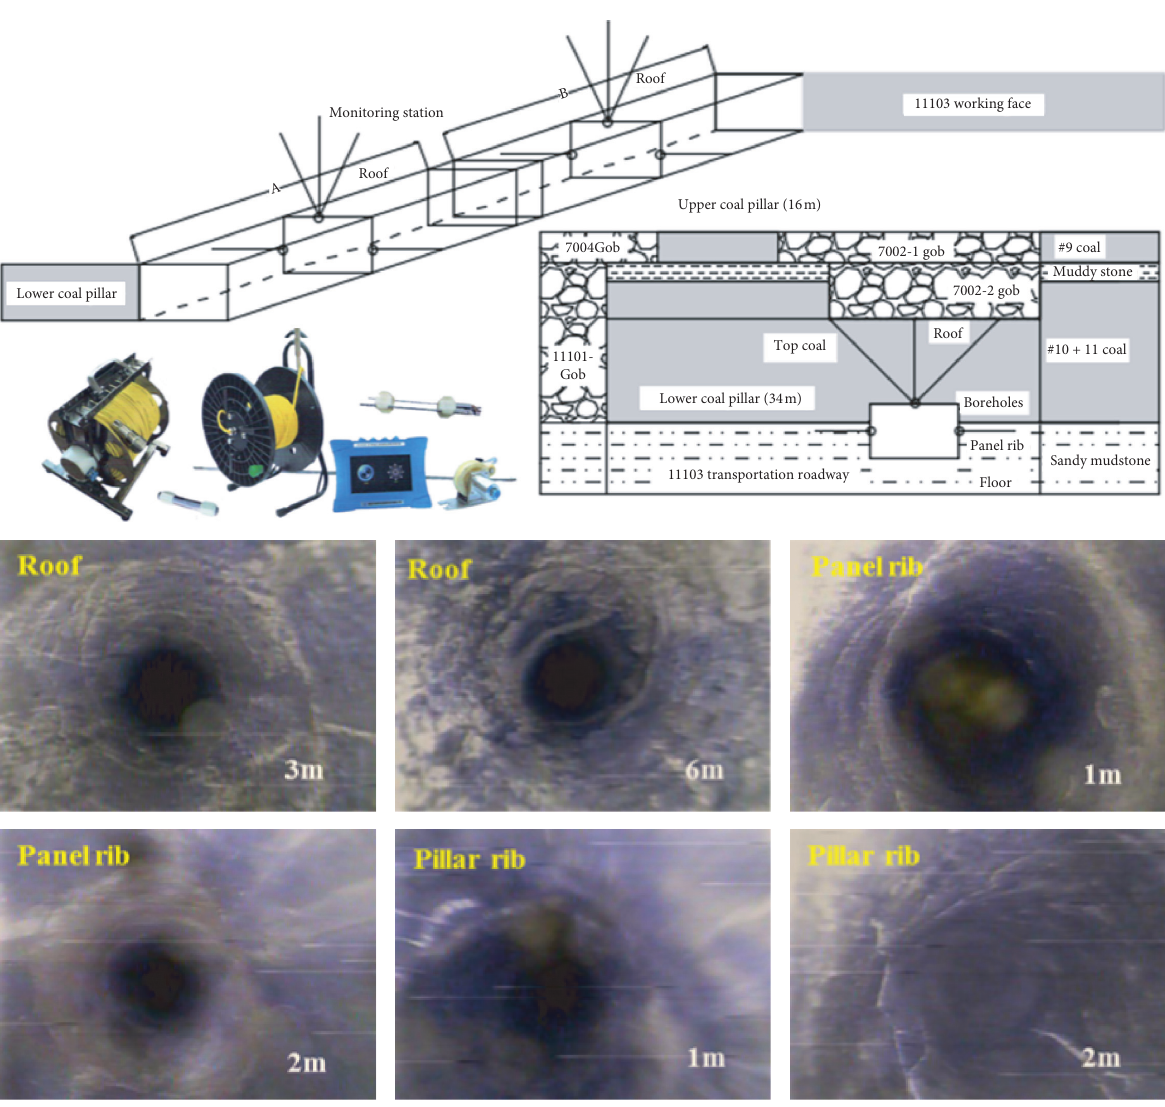
Figure 5: The borehole